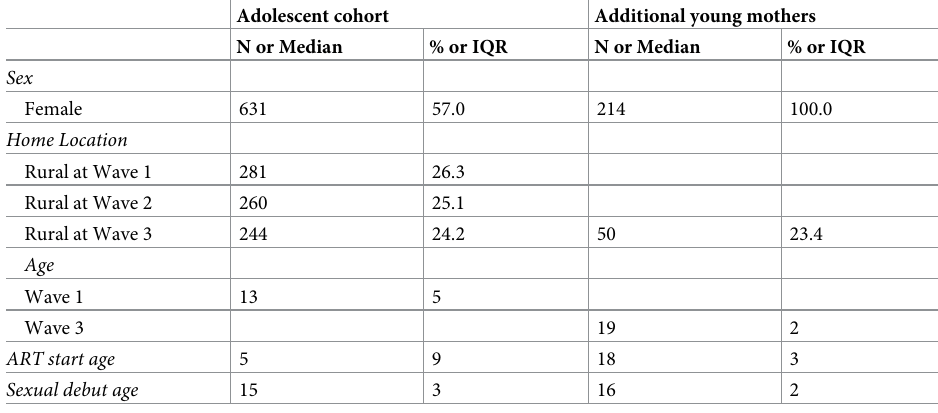
Table 1. Descriptive statistics of cohort adolescents living with HIV (N = 1107), and young mothers added at Wave 3 (N =